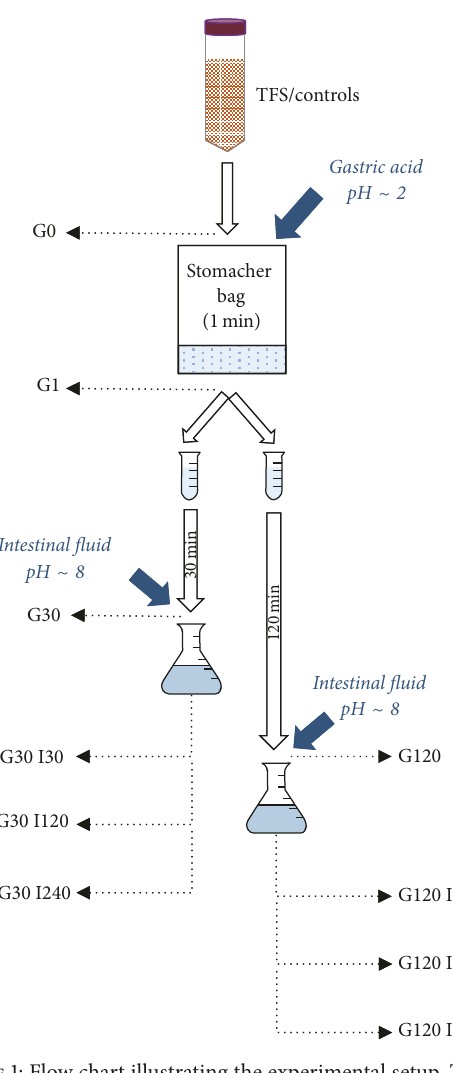
Figure 1: Flow chart illustrating the experimental setup. TFS (tube fermented sausage) and control batter (15 g) were transferred to separate stomacher bags, diluted 1: 10 in gastric acid solution, and stomached for 1min. Samples were transferred to tubes and incubated for 1, 30, and 120 min (samples G1, G30, and G120, resp.). Furthermore, intestinal fluid solution was added to samples after 30 and 120min (1:1). Sampling from G30 and G120 tubes was performed after 30, 120, and 240 min. Each experiment was repeated three times and included 2 sample types (fermented and controls) × 2 parallels × 5 E. coli strains. A total of 60 (3 × 20) samples were included for the digestion challenge